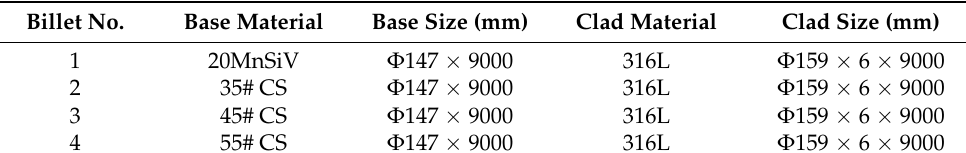
Table 2. Materials and specifications of the composite billets.